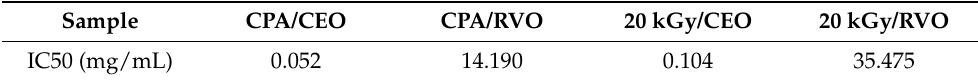
Table 3. Values of DPPH half maximal Inhibitory Concentration (IC50) of oil-loaded paper samples.